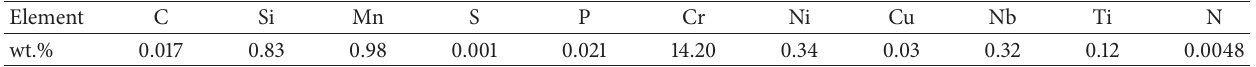
Table 1: Chemical composition of FSS 429 (wt.%).